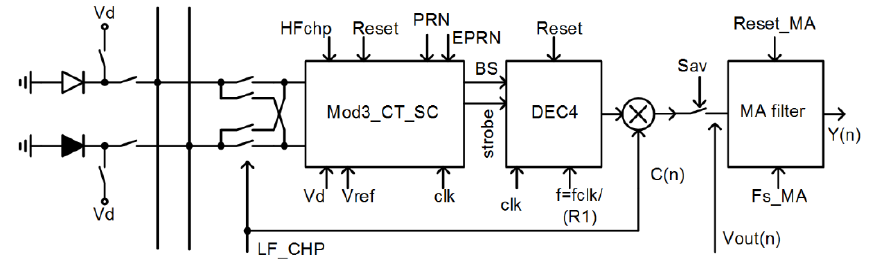
Figure 6. Simplified block diagram of the light-to-digital